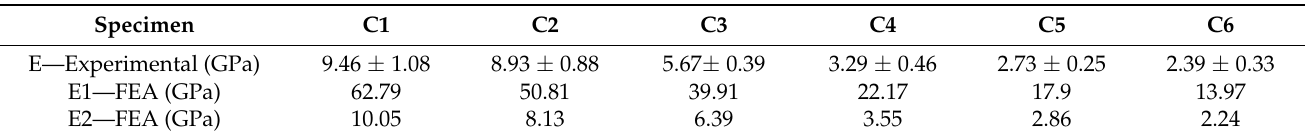
Figure 5. Relationship between the elastic modulus and porosity. ( a ) Compressive stress–strain curve of extracted elastic parts from Figure 3a for the calibration of FEA results; ( b ) comparison between experimental data and FEA results for C1 to C6 based on the Gibson–Ashby model. Table 3. Calibrated Young’s modulus E 2 of the FEA using the corrected E 0 = 17.92 GPa compared to the Young’s moduli obtained experimentally and the non-calibrated E 1 using the original E 0 = 112 GPa.